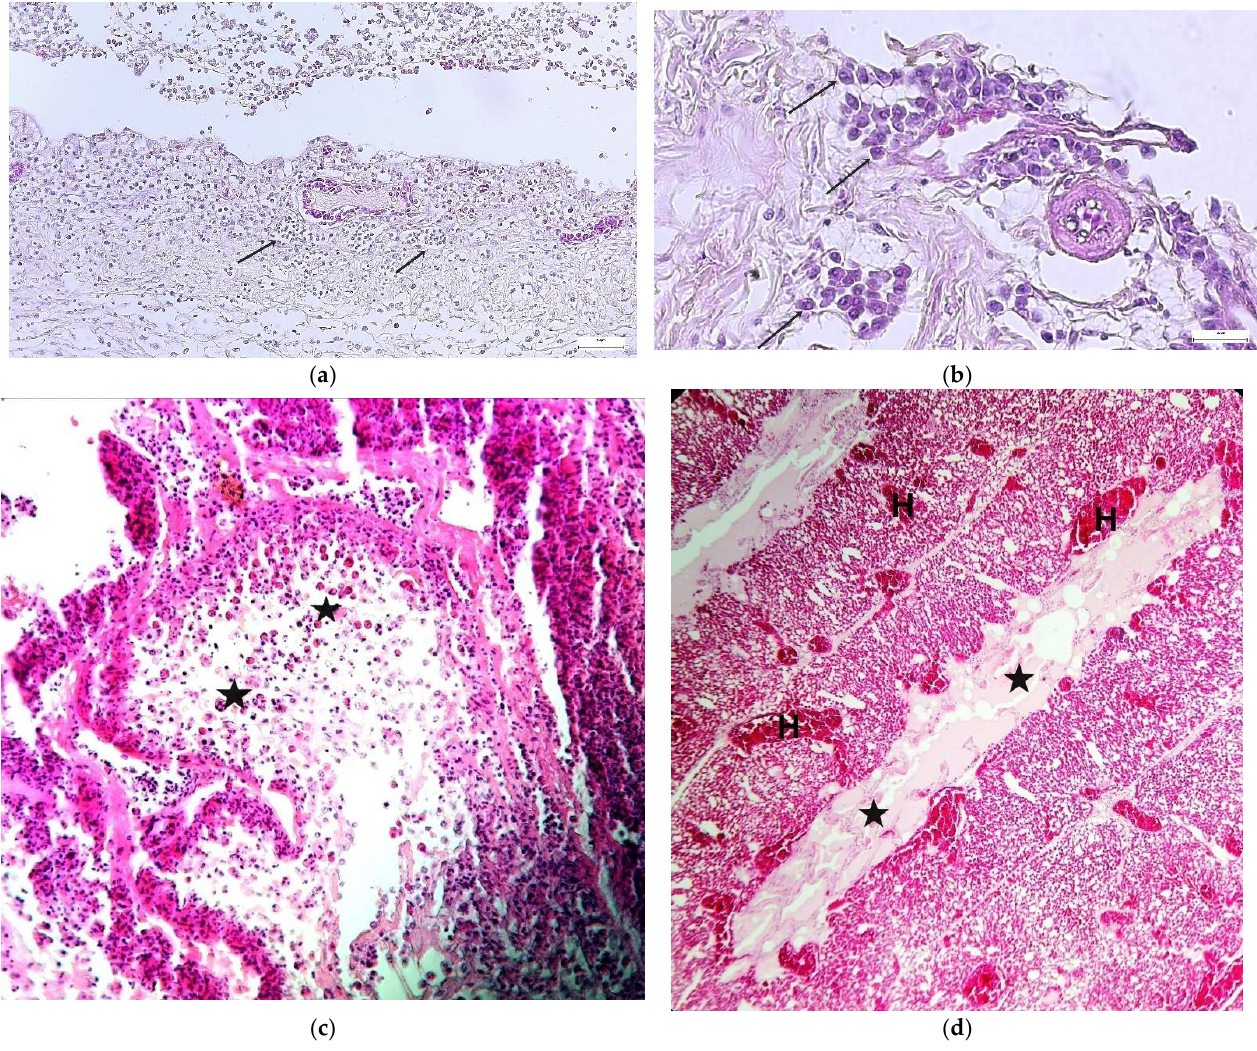
Figure 4. ( a ) Fibrinous exudate in the trachea with lymphocytic infiltration (arrows) in mucosa, H&E stain, magnification × 200; ( b ) larynx, large multinucleated syncytial cell showing many eosinophilic intranuclear inclusion bodies (arrows), H&E stain, magnification × 600; ( c ) Cross section of the trachea showing sloughed epithelial cells (stars), H&E stain, magnification × 200; ( d ) lungs. Hyperemia in blood vessels (H) and endemic fluid in the lung tissue (stars), H&E stain, magnification × 100.